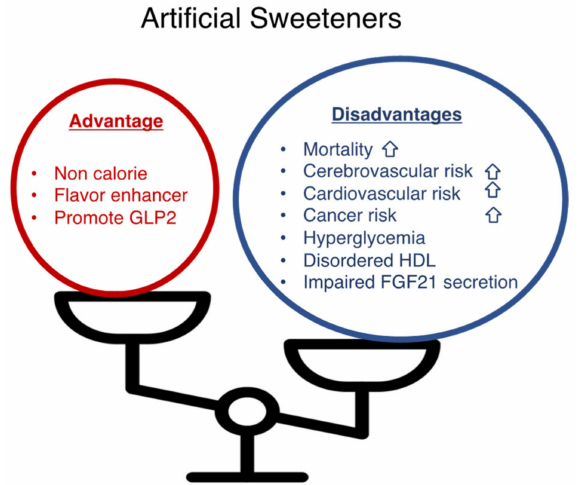
Figure 2. Artificial sweeteners have advantages and disadvantages. Artificial sweeteners (sucralose, saccharin, aspartame, and acesulfam K) present advantages (non-caloric; a flavor enhancer; a GLP-2 stim- ulant) and disadvantages (increased mortality, cerebrovascular risk, cardiovascular risk, hyperglycemia, increased plasma HDL levels with impaired antioxidant functions, impaired FGF21